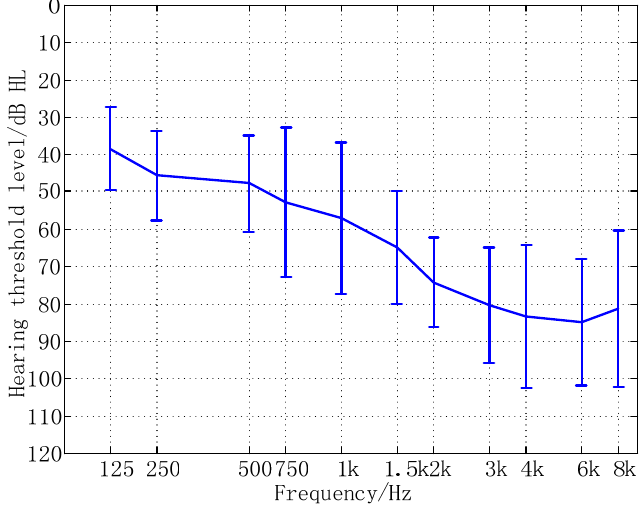
Figure 5. Mean hearing thresholds and SDs for hearing-impaired subjects.